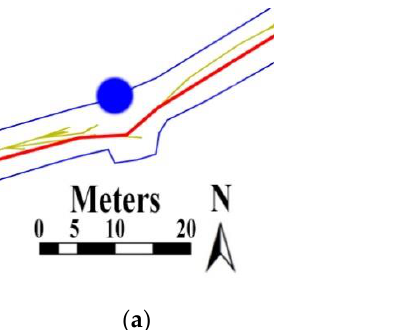
Figure 15. The simulation result with known obstacles. ( a ) With avoidable obstacles; ( b ) with unavoidable obstacles.